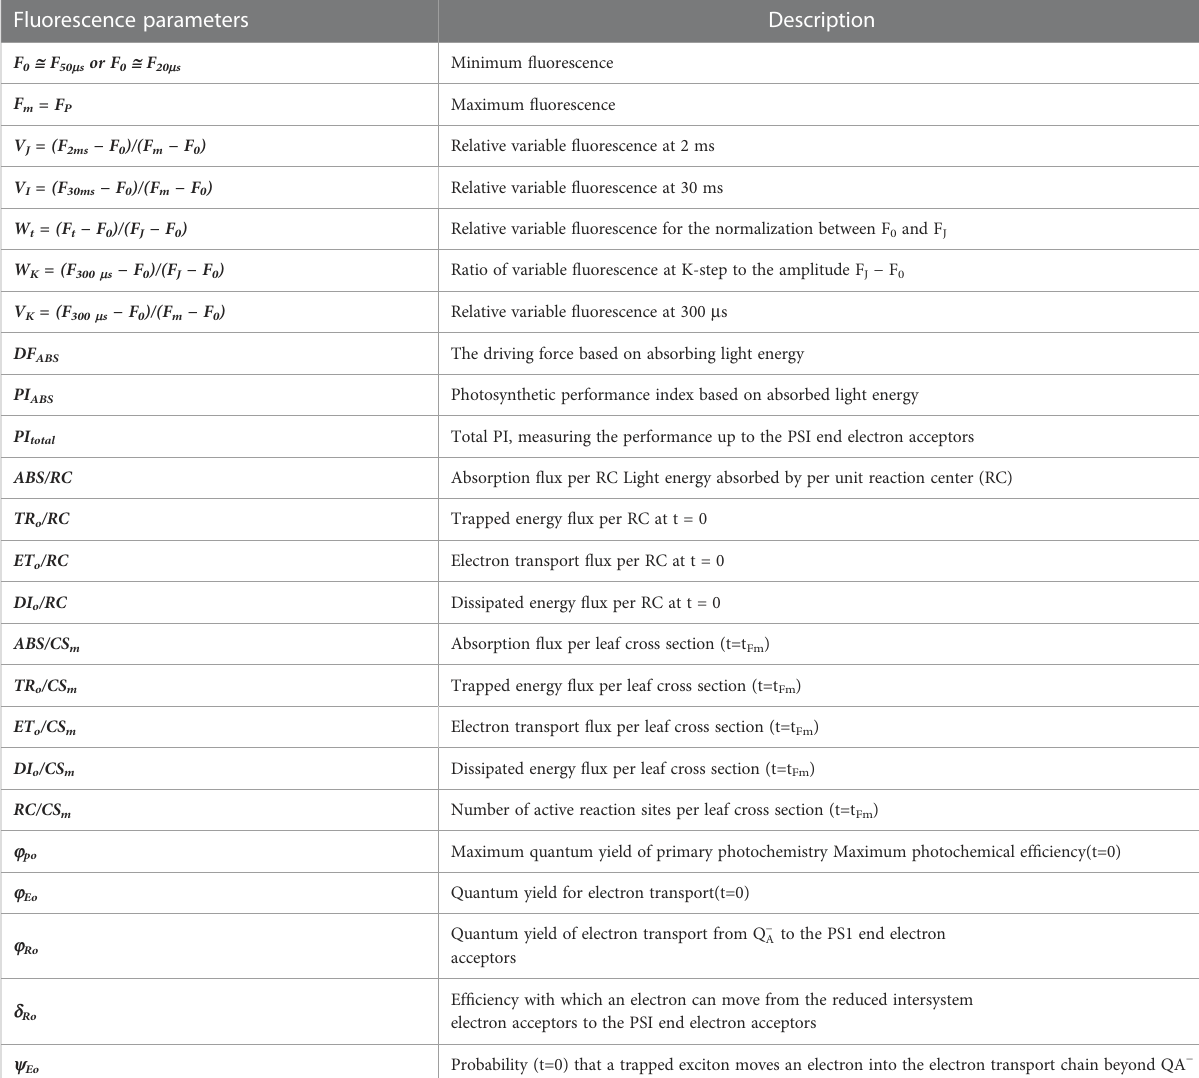
TABLE 2 The ChlF parameters used in this study. Fluorescence